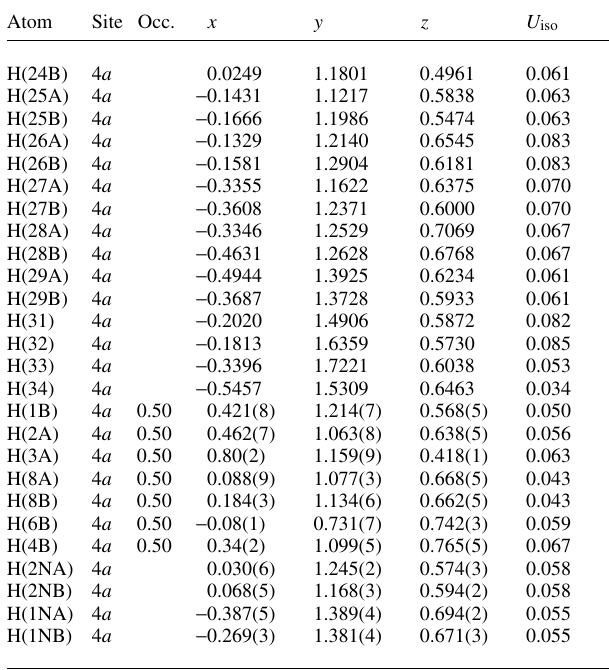
Table 1. Data collection and